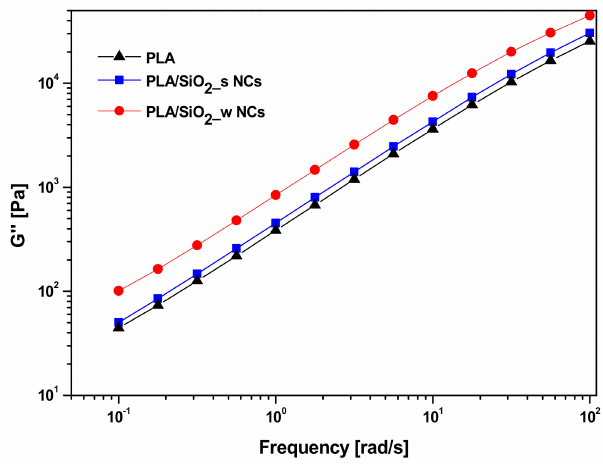
Figure 9. Loss Modulus G” of pure PLA and PLA / SiO 2_ s and PLA / SiO 2_ w